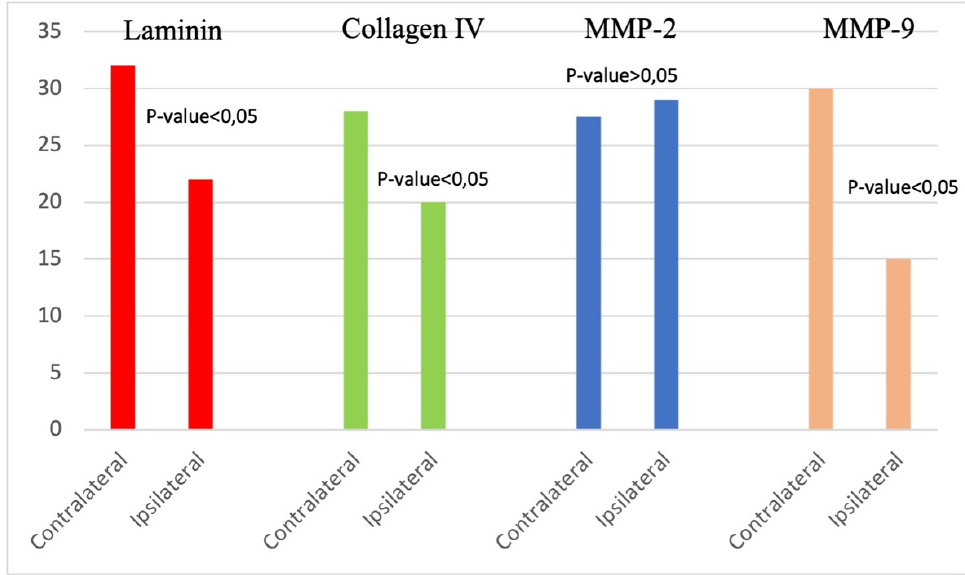
Figure 5. The graphic shows the means of fluorescence intensity for each tested proteins both in the contralateral and the ipsilateral muscles. The means were obtained by the function “Histo” of confocal laser microscope. Laminin, Collagen IV, and MMP-9 are more expressed in the contralateral muscle than in the ipsilateral one. For the MMP-2 the values for contralateral and ipsilateral muscles are close to each other.